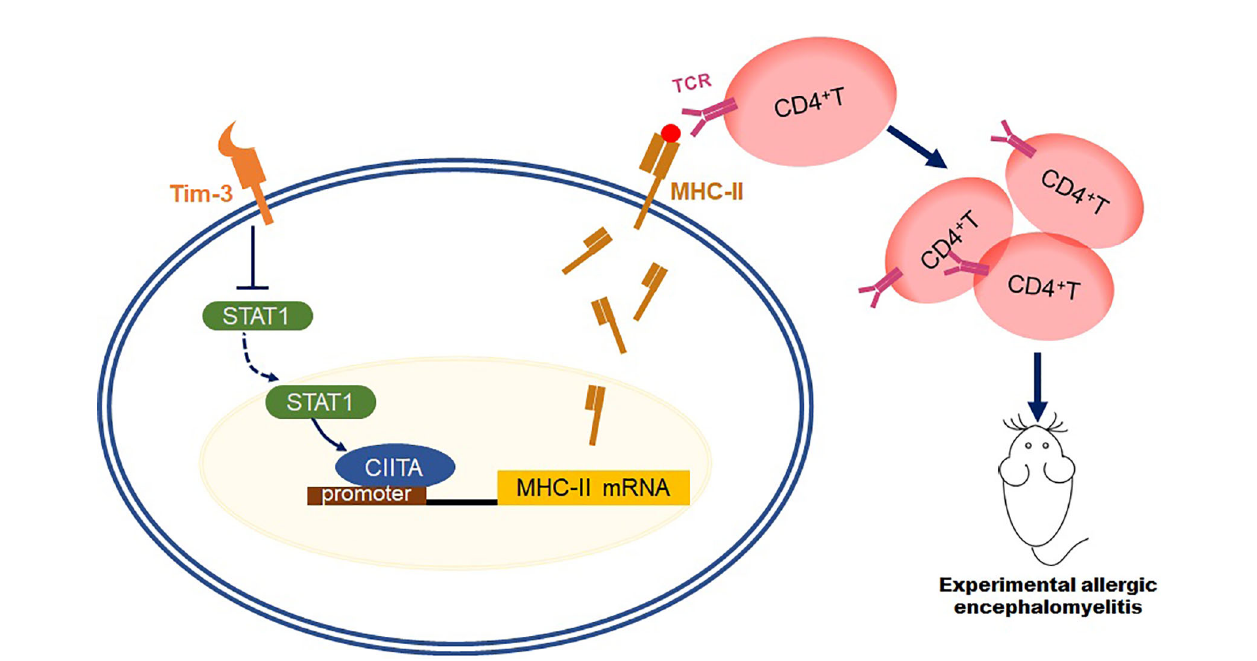
FIGURE 7 | Schematic diagram of how Tim-3 inhibits MHC-II expression and relieves the EAE model. This schematic diagram demonstrated that Tim-3 suppresses MHC-II expression in macrophages via the STAT1/CIITA pathway, and Tim-3 inhibits MHC-II-mediated autoantigen presentation and CD4+T cell activation, which facilitated experimental autoimmune encephalomyelitis in